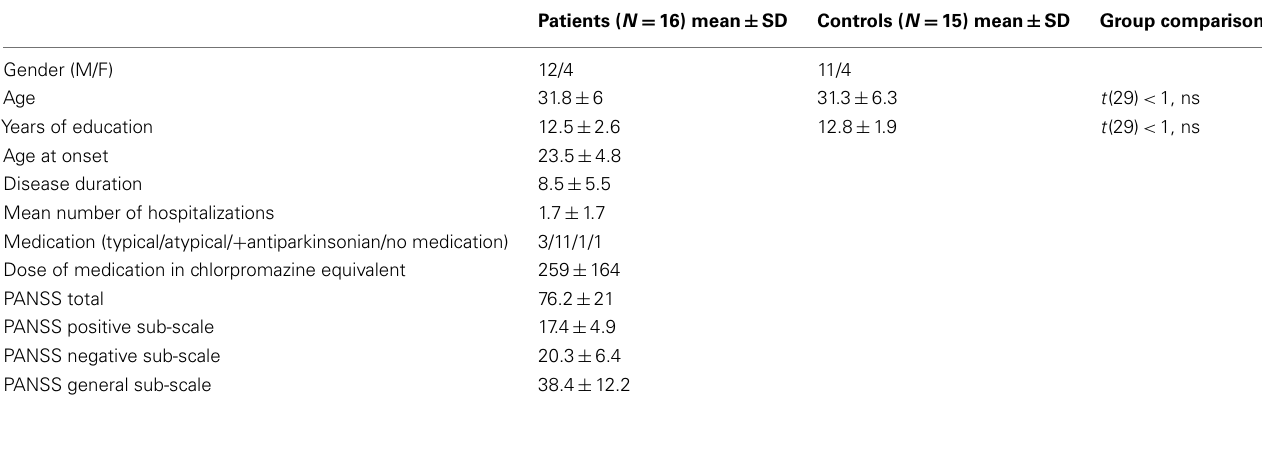
Table 1 | Demographic and clinical data of the